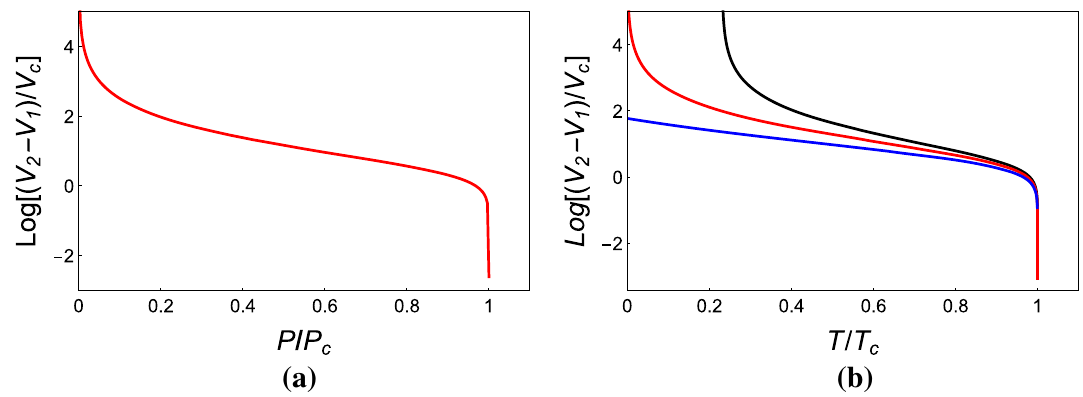
Fig. 2 a (cid:5) (cid:13) V as a function of (cid:13) P is independent of the parameter x . b (cid:5) (cid:13) V as a function of (cid:13) T with x = 0 . 3, 0 and − 0 . 3 from top to bottom